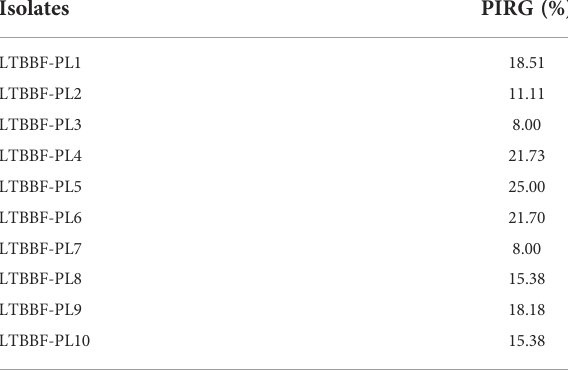
TABLE 1 Inhibition (%) of growth of Sporothrix brasiliensis by antagonistic Purpureocillium lilacinum on potato dextrose agar at 7